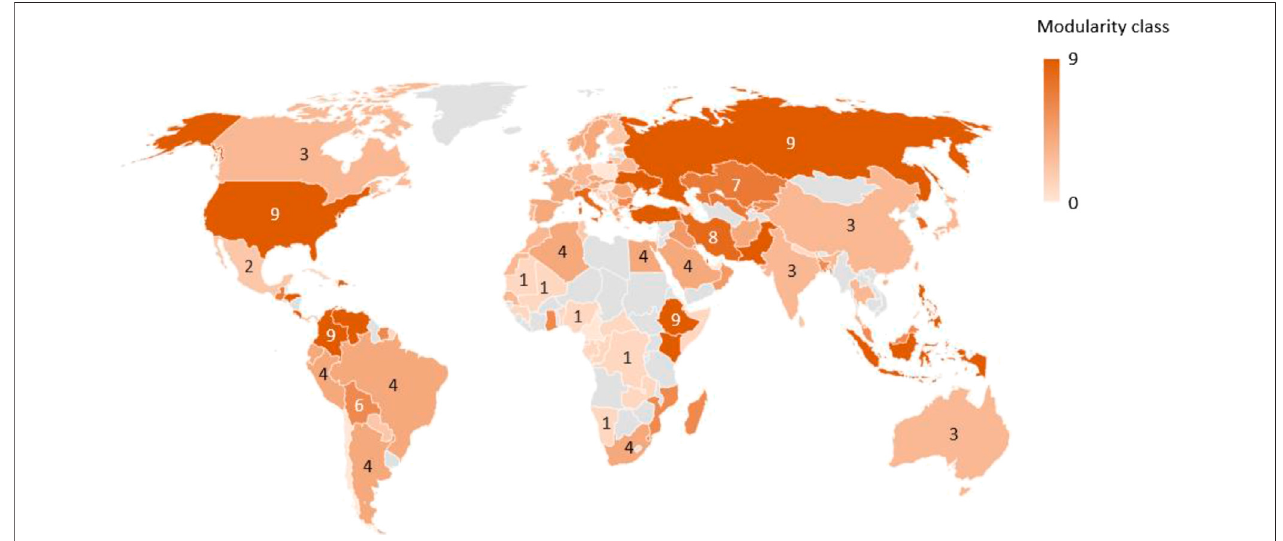
FIGURE 10 | The modularity class of the global COVID-19 pandemic network.